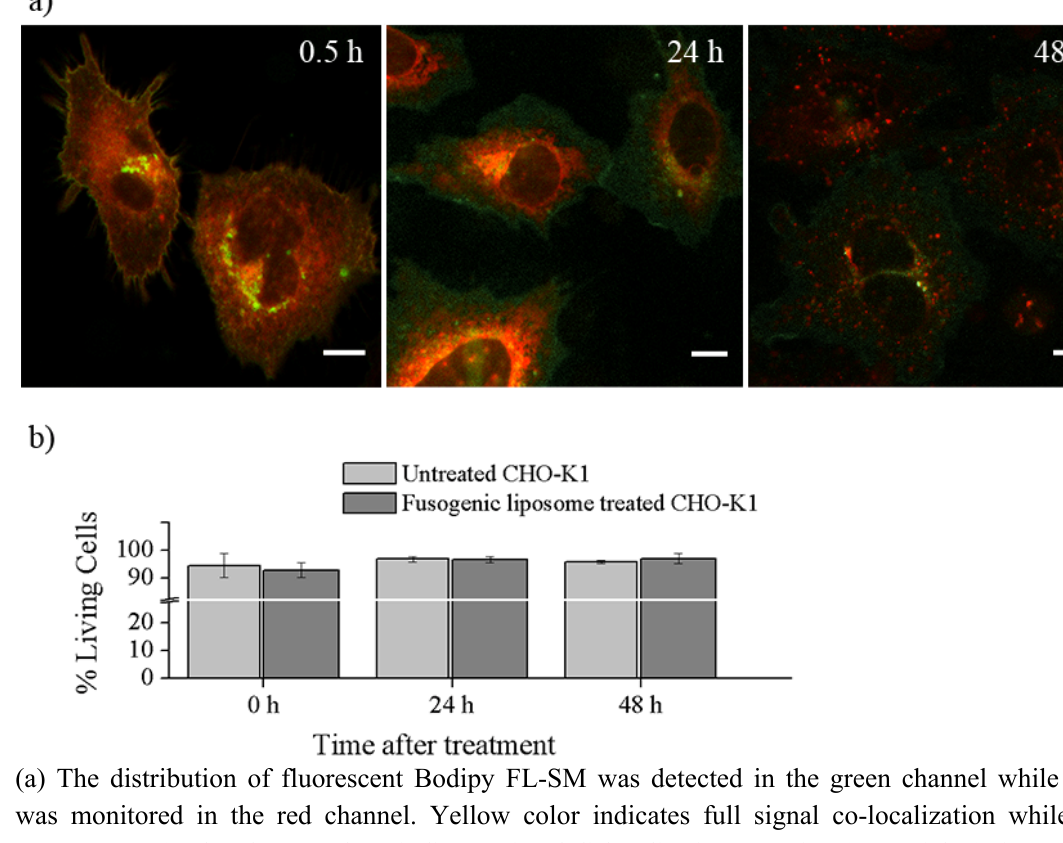
Figure 4. Cellular distribution of Bodipy FL-SM and DiR in CHO-K1 cells after incorporation via fusogenic